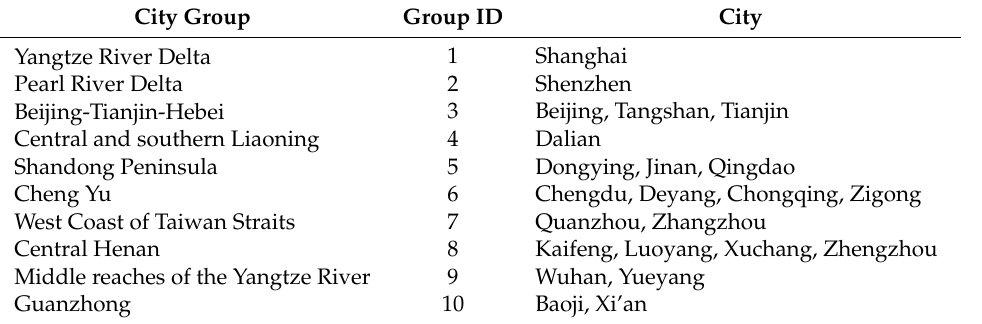
Table 5. The PM 2.5 environmental efficiency frontier cities based on the group-frontier during 2004 to 2016.